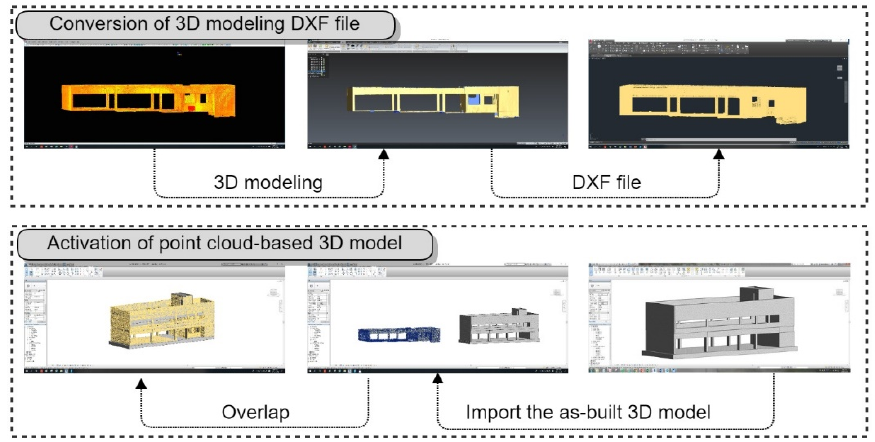
Figure 2. Comparison of the building information modeling (BIM) model and the point cloud-based